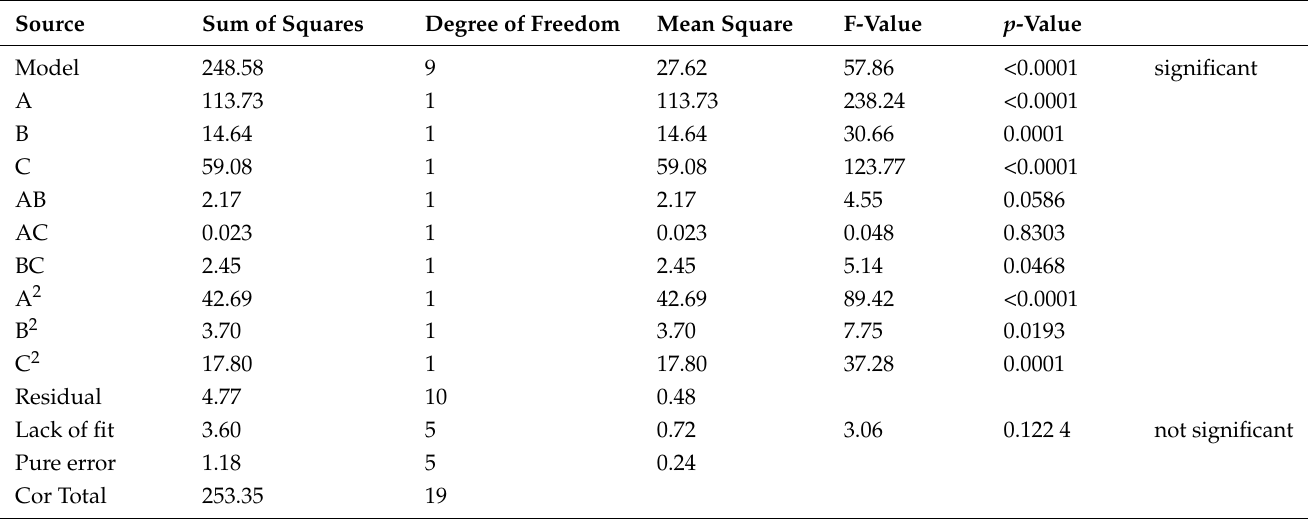
Table 2. Analysis of variance and reliability of regression